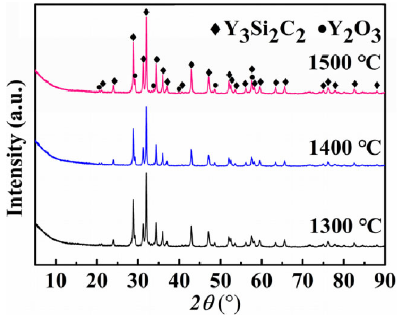
Fig. 1 XRD patterns of the samples sintered at various temperatures by reactive